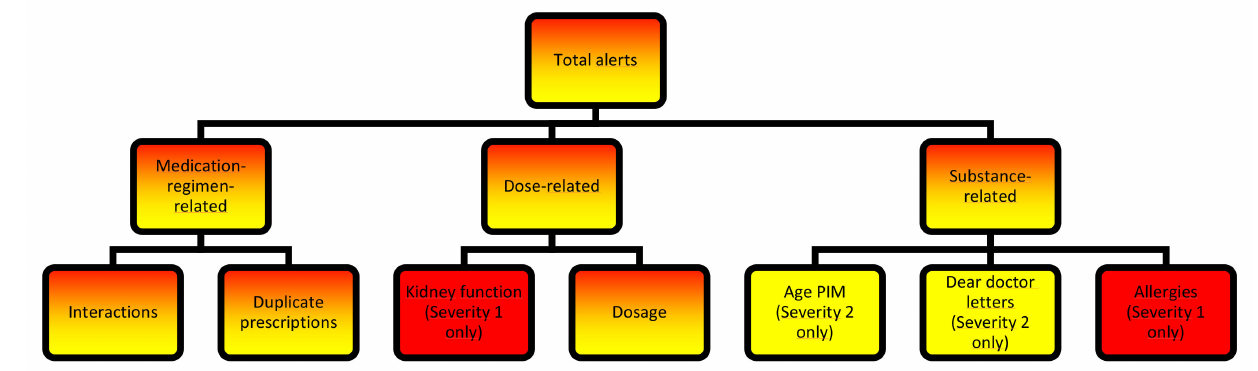
Figure 9. Alert categories documented by the software. Red font indicates alerts of the highest severity, and yellow font indicates medium severity.